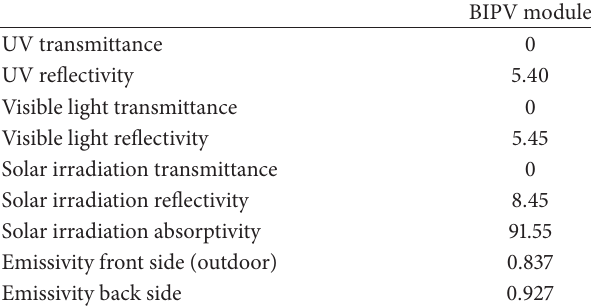
Table 1: Optical properties of the proposed